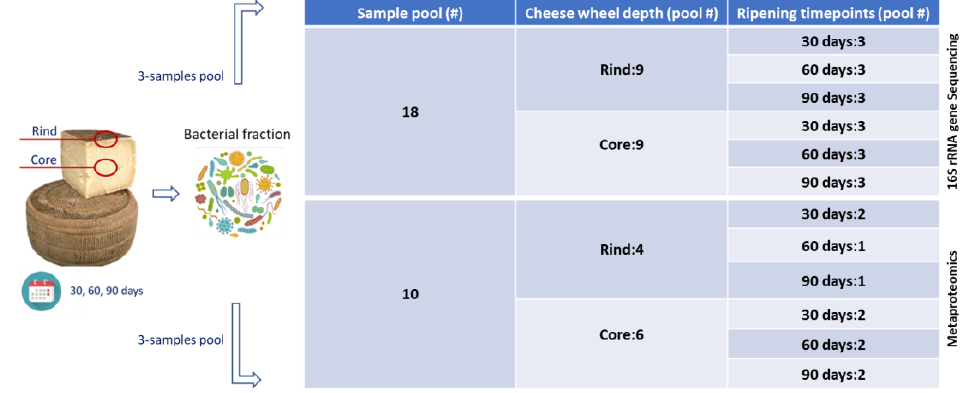
Figure 7. Experimental design and sampling strategy.